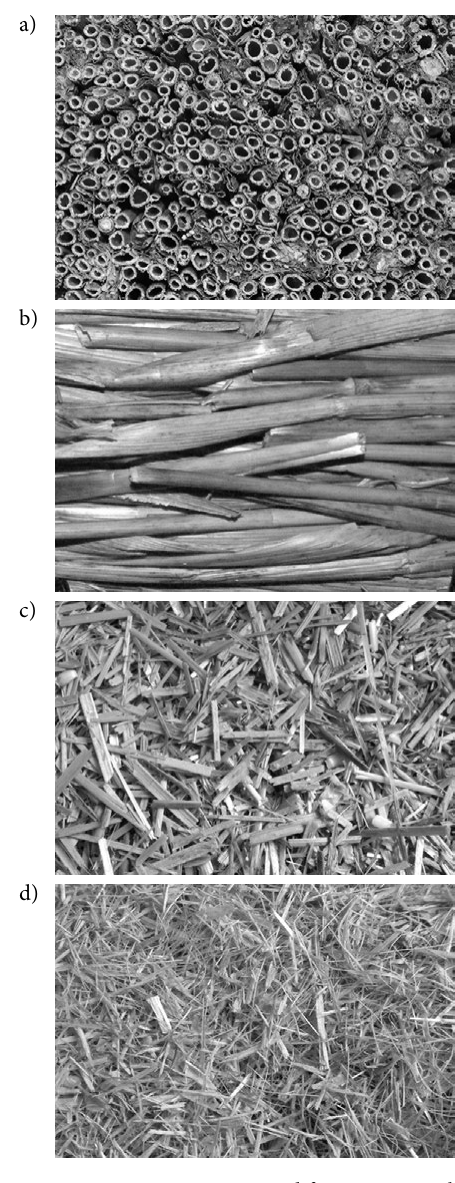
Fig. 1. Straw specimens prepared for measuring